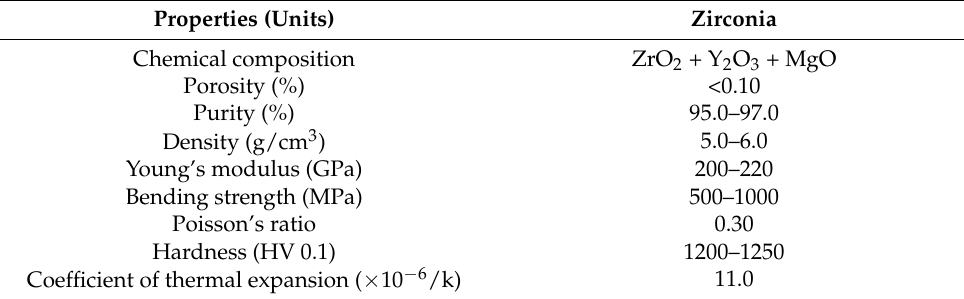
Table 3. Properties of pure zirconia